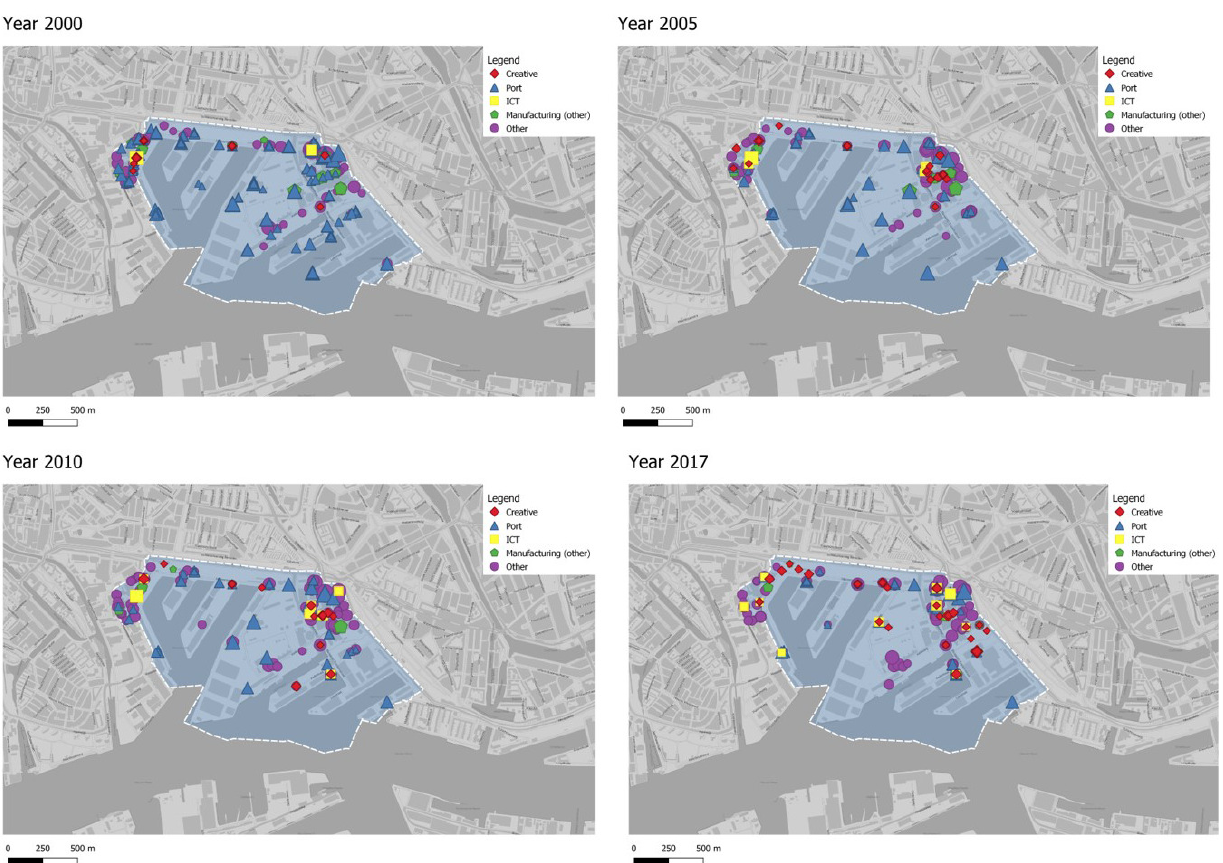
Figure 4. Companies in M4H by sector, 2000–2017. The symbol size represents the number of jobs. Source: Figure by Erasmus UPT (2020), based on LISA (2017) and Publieke Dienstverlening op de Kaart